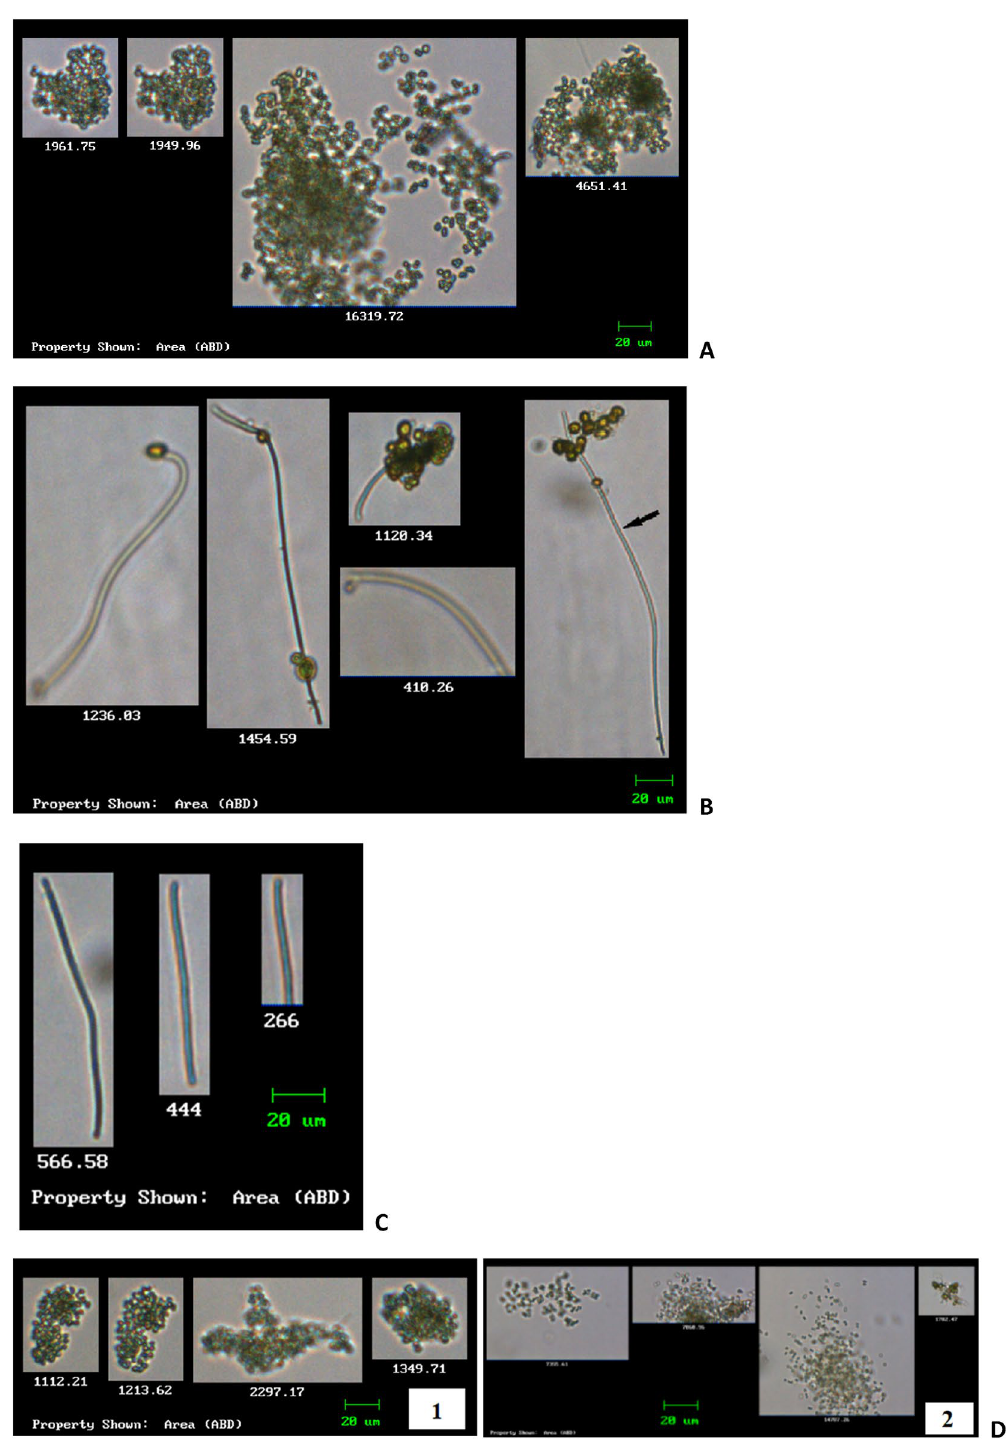
Figure 3. Representative FlowCAM images of genus Microcystis sp. ( A ) obtained from the SD-2 water sample; Leptolyngbya sp. ( B ) and Phormidium sp. ( C ) obtained from the SD-1 water sample; and Microcystis sp. ( D1-2 ) obtained from the SM-1 and SM-2 water samples, respectively. All images are < 20 µm in